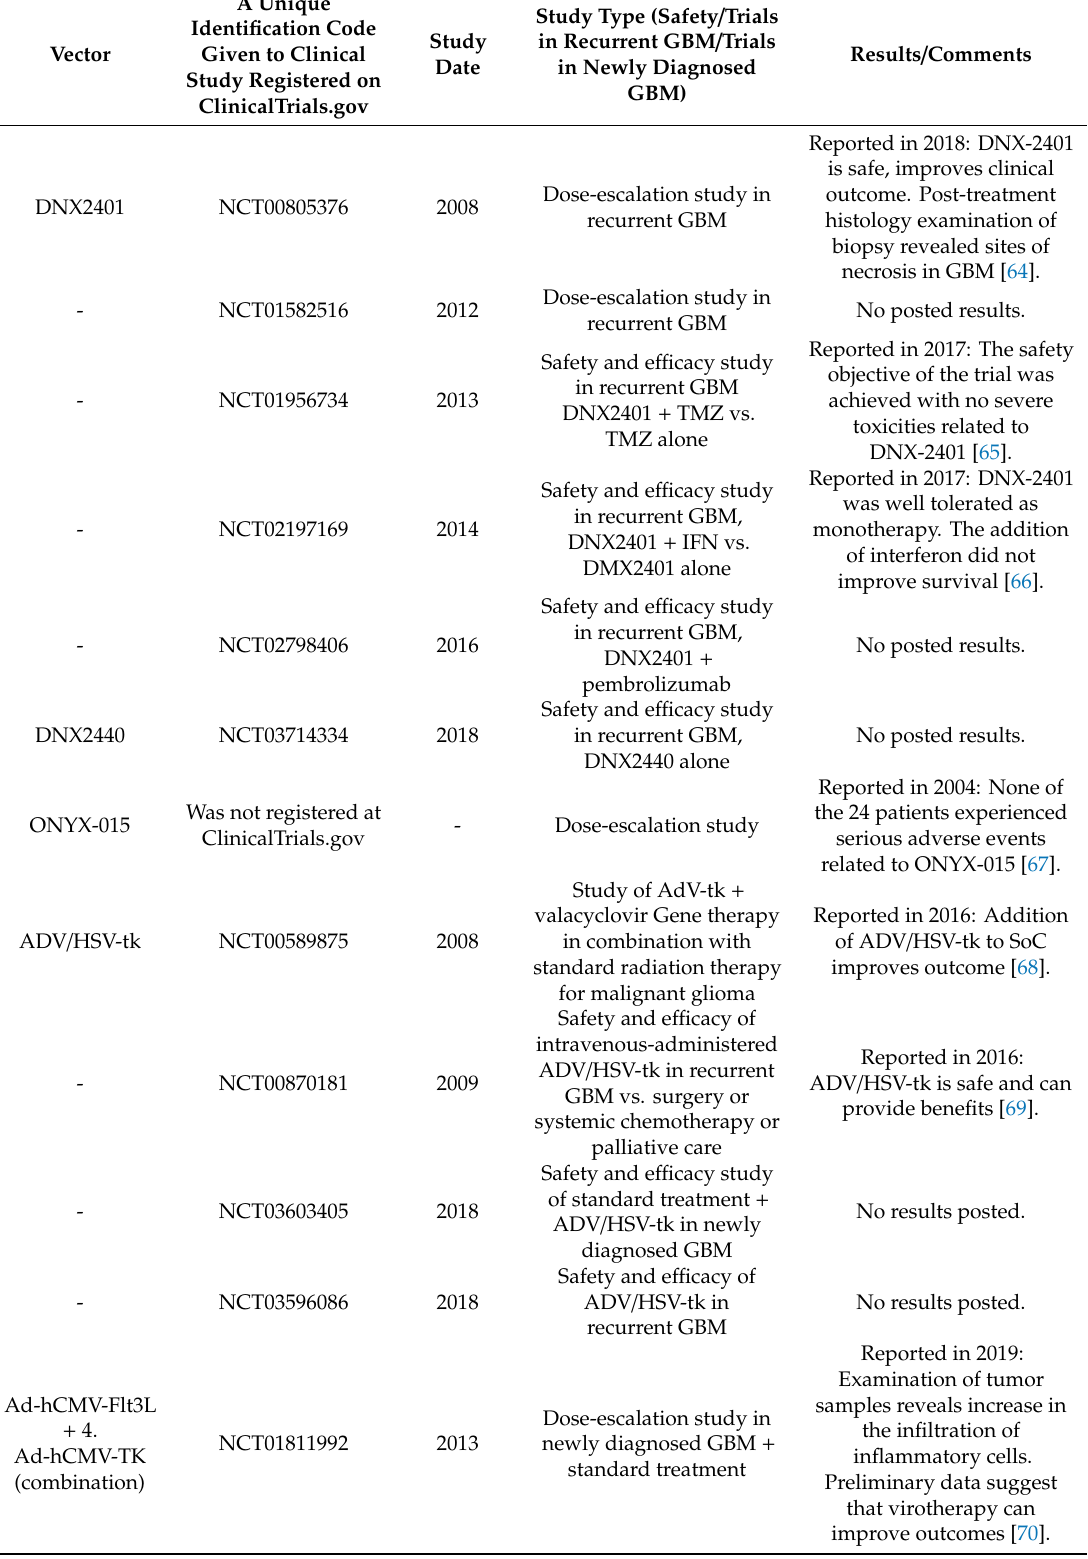
Table 2. Clinical trials using viral